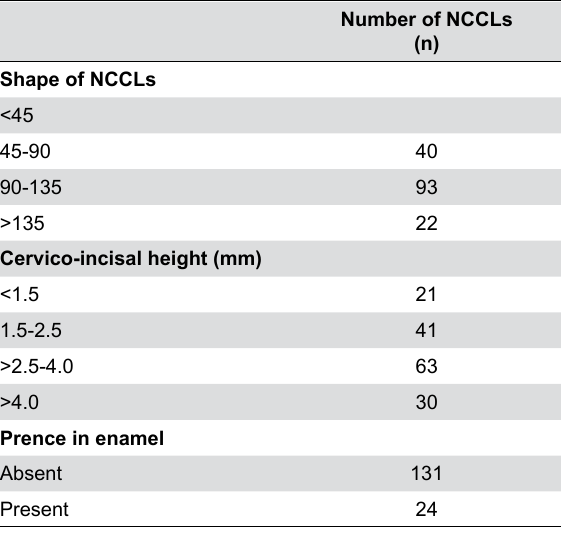
Table 3- Characteristics of non-cervical caries lesions (NCCLs) included in the